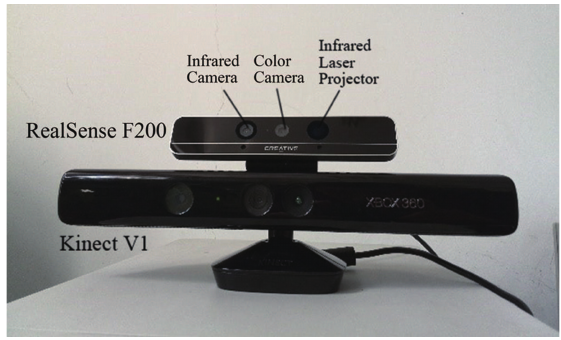
Figure 1. RealSense F200 vs. Kinect V1. Table 1. Comparison of the main official parameters of regular somatosensory cameras.